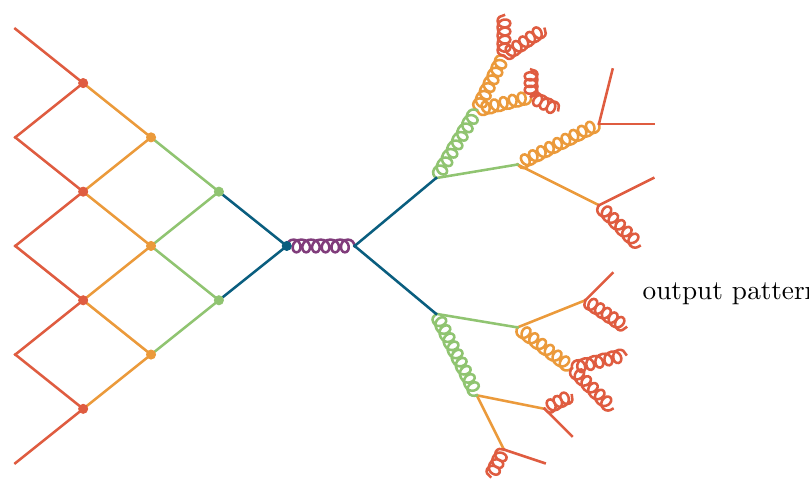
Figure 1 . Comparison between the structure of a convolutional autoencoder and a parton shower. A pattern is input on the left and the value at each network node is determined by the weighted sum of the connected